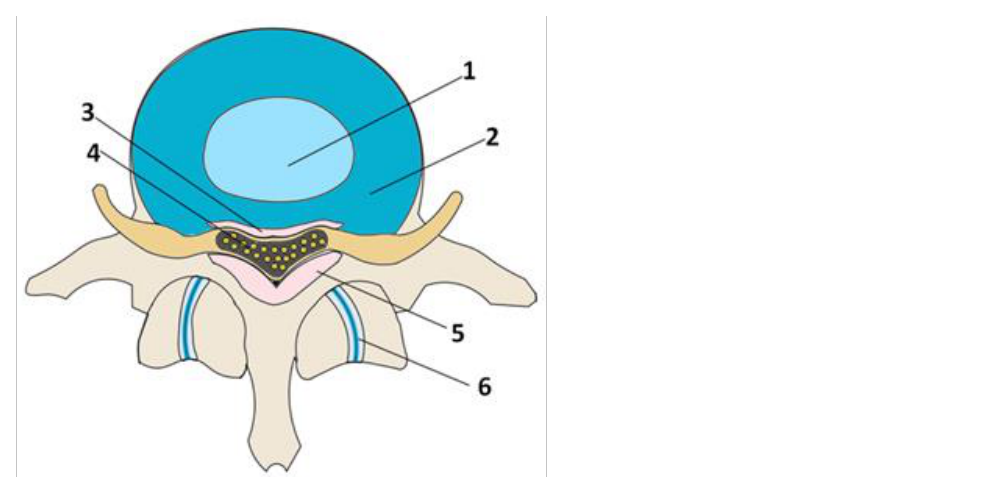
Figure 2. Schematic representation of the spinal motion segment: 1—nucleus pulposus; 2—annulus fibrosus; 3—posterior longitudinal ligament; 4—spinal cord; 5—ligamentum flavum; 6—facet joints.